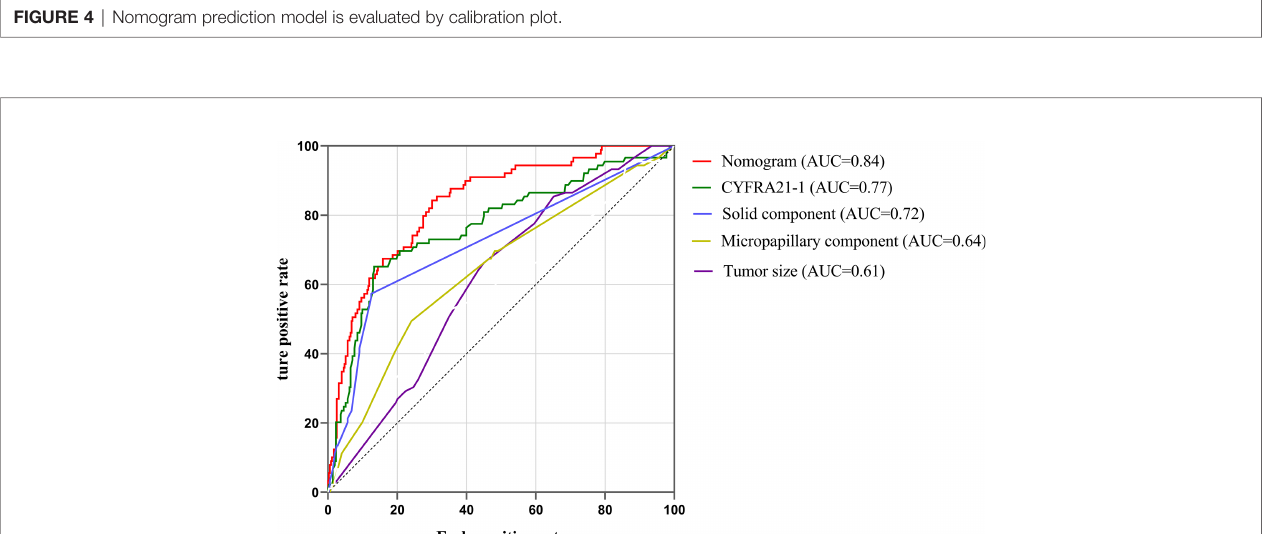
FIGURE 5 | ROC curves of nomogram, CYFRA21-1, solid component, micropapillary component and tumor sizes. ROC, Receiver operating characteristic; AUC, area under the curve.